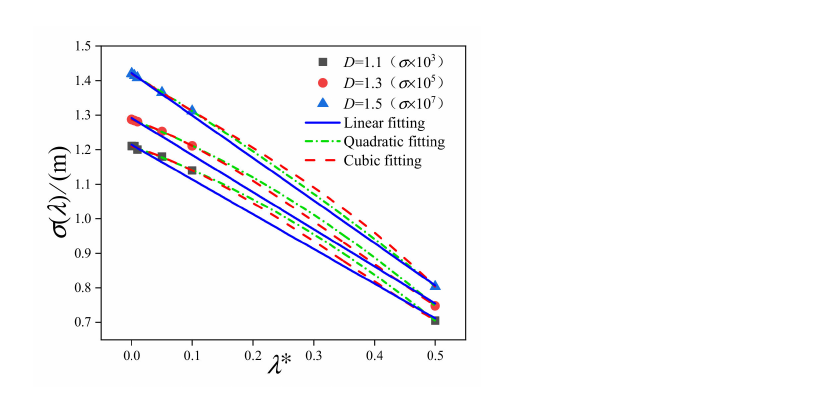
Figure 3. The different fitting curves between the dimensionless observation length and the standard deviation at different fractal dimensions ( D ≤ 1.5).